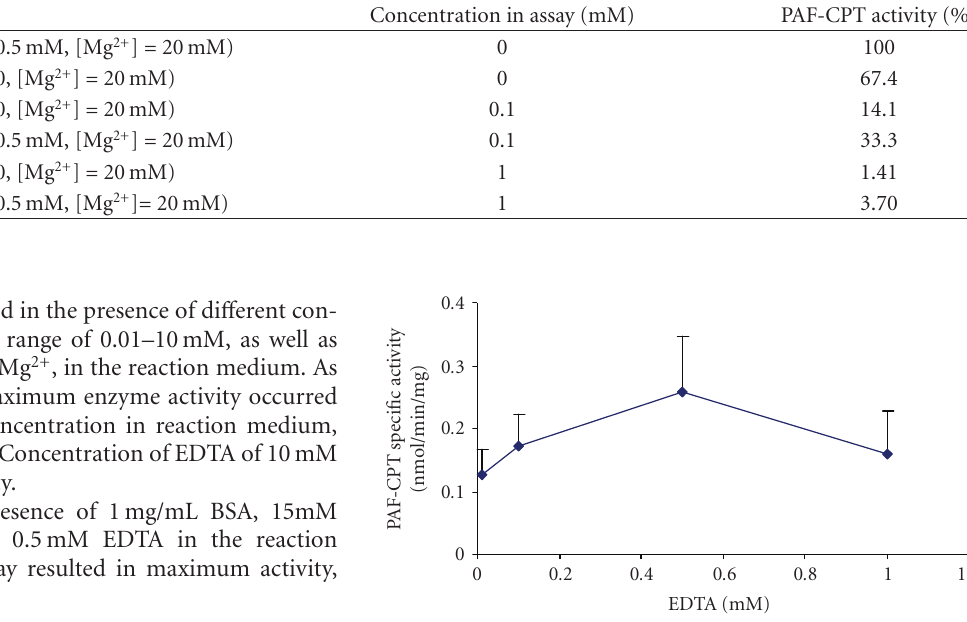
Table 3: E ff ect of Ca 2+ cation on PAF-CPT activity of HMC. Results represent the average of two independent experiments using di ff erent enzyme preparations performing duplicate samples.